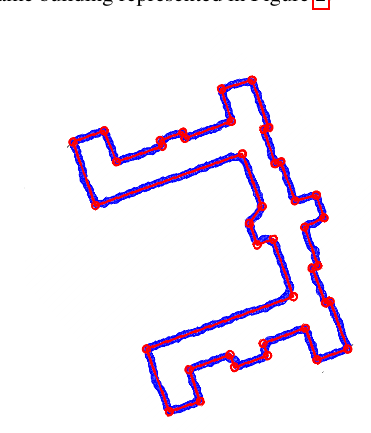
Figure 3: Approximation of polygon obtained using RANSAC